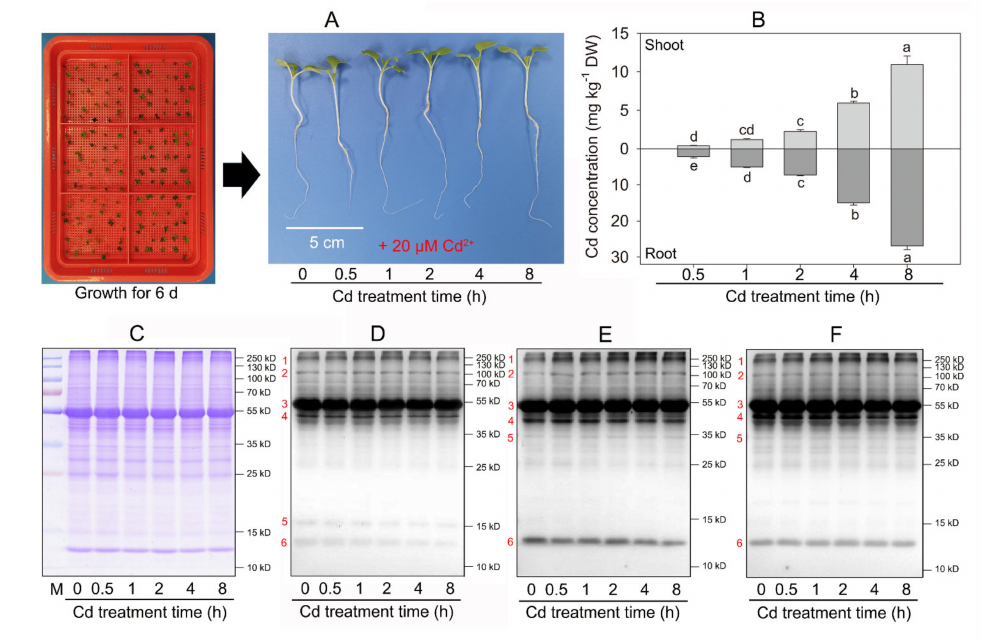
Figure 1. Plant seedling treatment, Cd concentration, and Western blotting (WB) analysis of three acylation modifications of turnip under Cd treatment (20 µ M) for different times. ( A ) Treatment mode and morphology of plant seedlings; ( B ) Cd concentrations in turnip seedlings. Data represent means ± standard deviations ( n = 3); bars labeled with different letters indicate significant differences ( p < 0.05) between different samples; ( C ) A representative SDS–PAGE gel stained by Coomassie brilliant blue to reflect the protein loading control (15 µ g lane − 1 ); ( D ) WB results of acetylation modification; ( E ) WB results of succinylation modification; ( F ) WB results of crotonylation modifica- tion. The relative fluorescence intensity of the bands labeled with Arabic numbers is shown in the Supplementary Materials, Figures